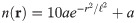
Time evolution of a epidemic starting from two infection centers near a heavily populated region, see (a) (top-left panel); t is the time given in days, and x and y are the spatial Cartesian coordinates. n is non-uniform and given by n(r)=10ae-r2/ℓ2+a, with ℓ = 10 and a taken such that the spatial average of n is 0.2; see Fig SI-1 in S1 File for illustration. The global value of b is the same as in previous figures, B = 10−3, and all other populations are initially zero everywhere: w = f = r = 0. Panels (b)-(f) show the spread of the symptomatic population f as time progresses. The symptomatic population quickly spreads into the denser region in the center and its density there increases dramatically. The global sub-population fractions, and the cumulative fraction of infected population 1 − H, are shown in panels (g) and (h), respectively.